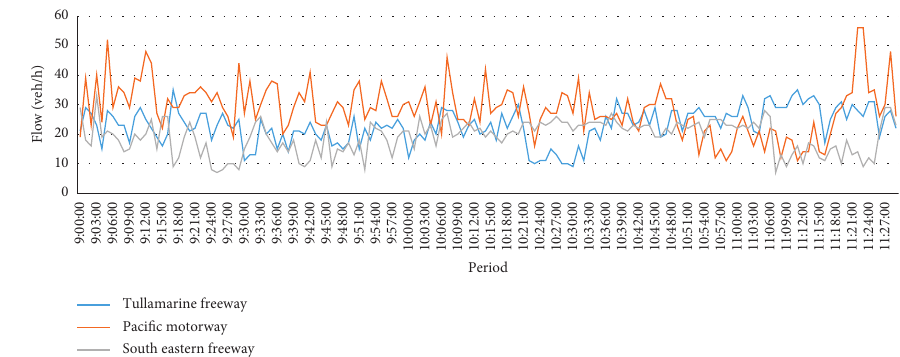
Figure 5: Samples of flow data for the three freeways.